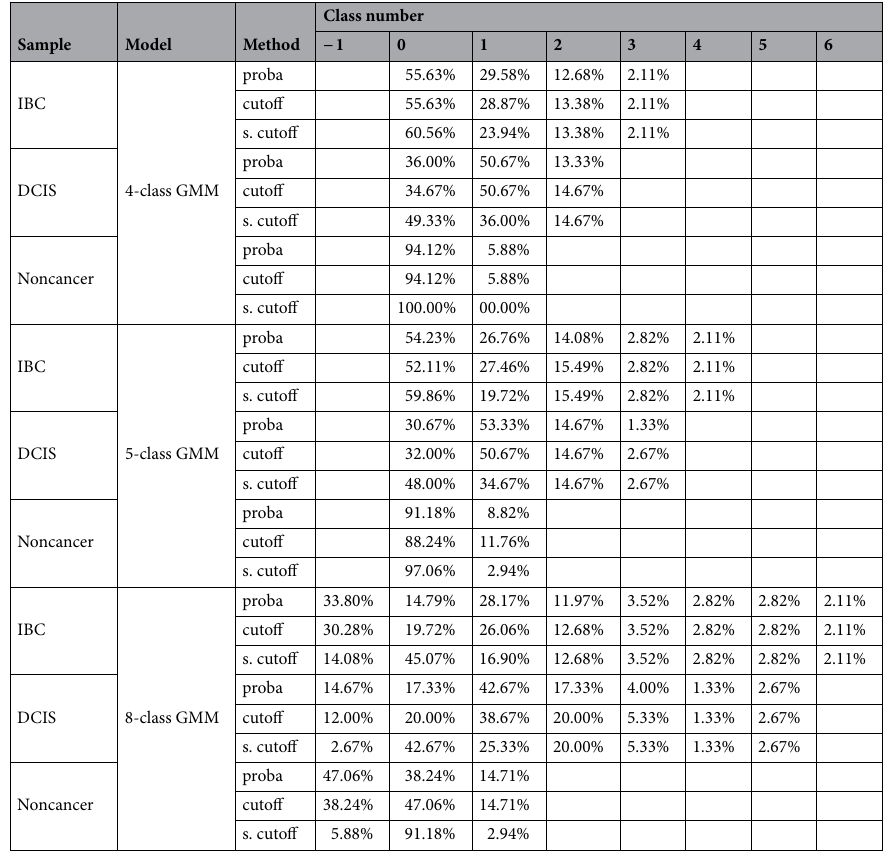
Table 1. Summary of multiclass classification of breast tissue on ERBB2 mRNA.